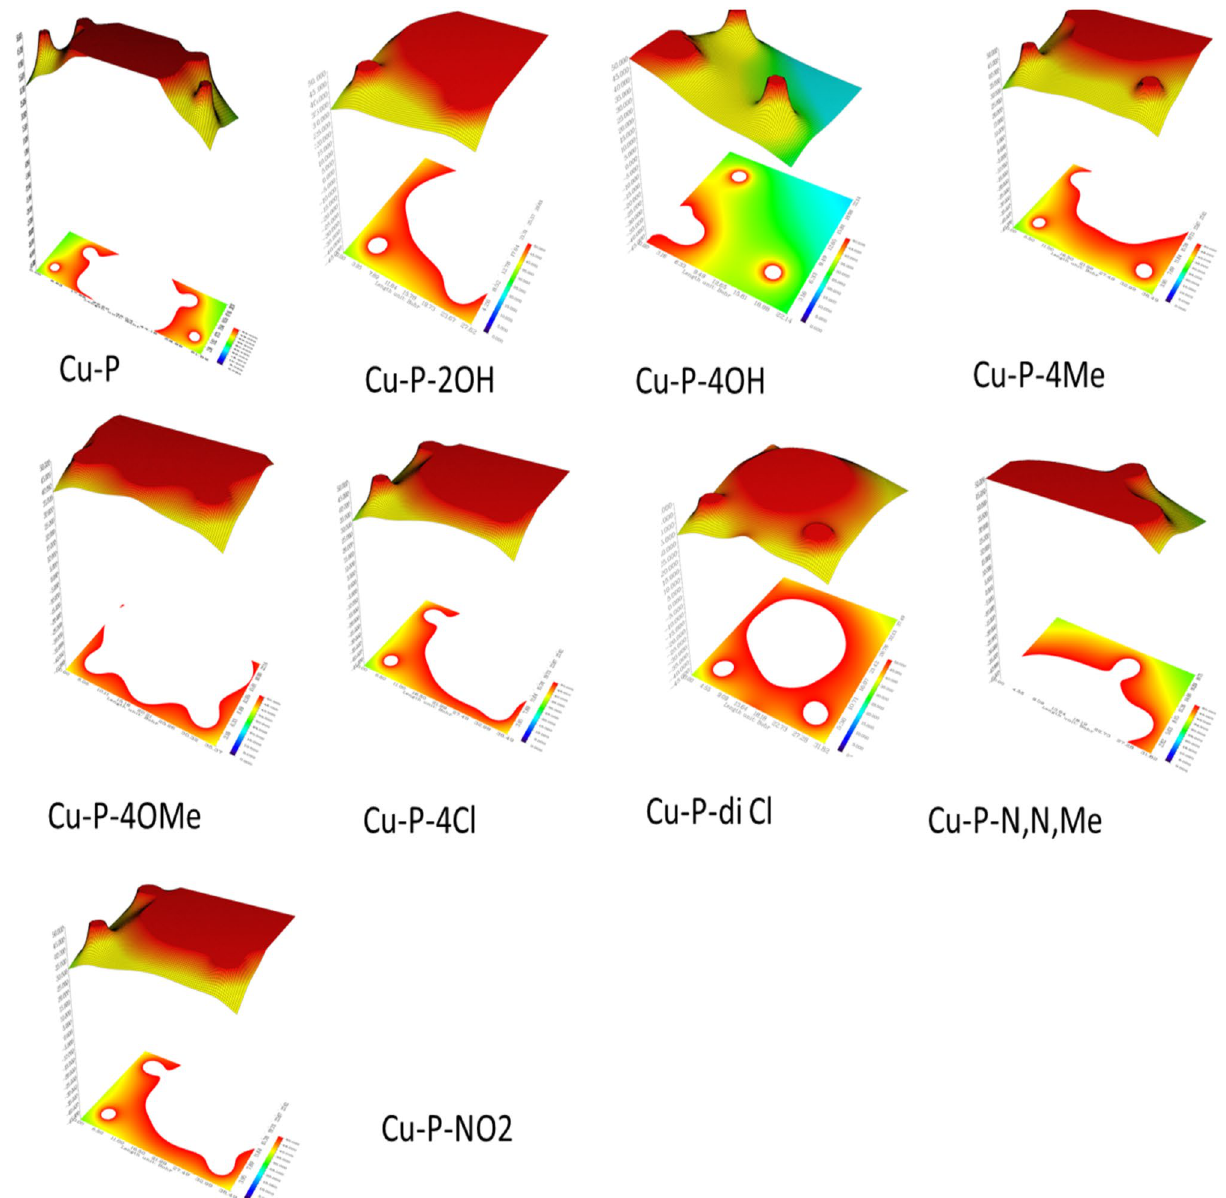
Figure 6. Electrostatic potential from nuclear charges of Cu complexes of pyrazoloquinolines derivatives profiles (https:// www. wavef un.